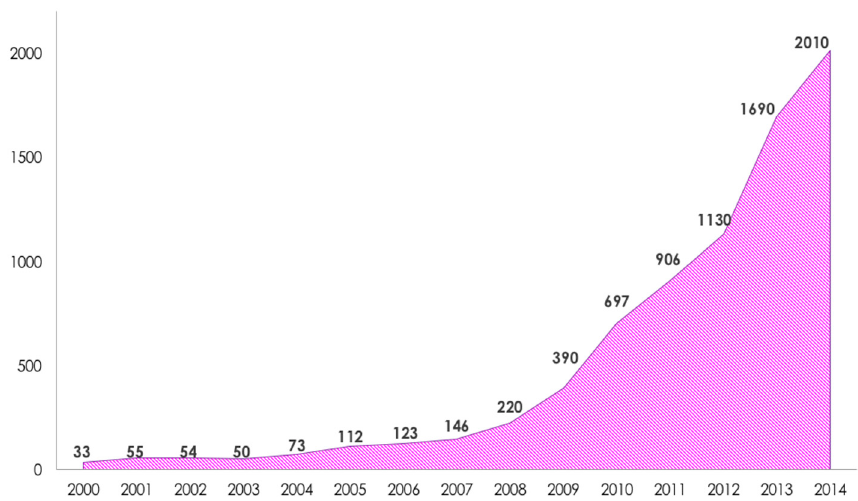
Figure 1. Number of papers published in the period 2000–2014 and containing an explicit reference to “computational social science” in the title (source: Google Scholar).